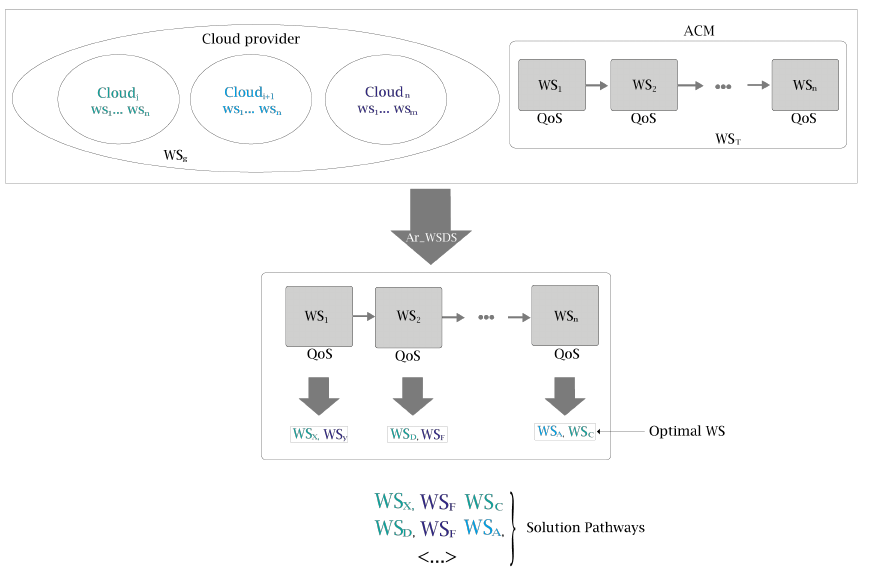
Figure 5. Example of Ar_WSDS